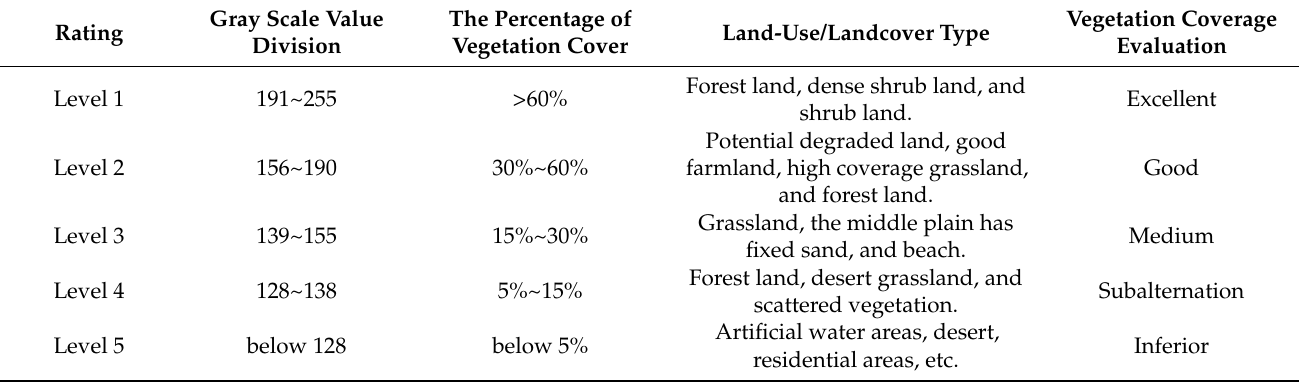
Table 2. Gray scale value and vegetation coverage equivalent distribution